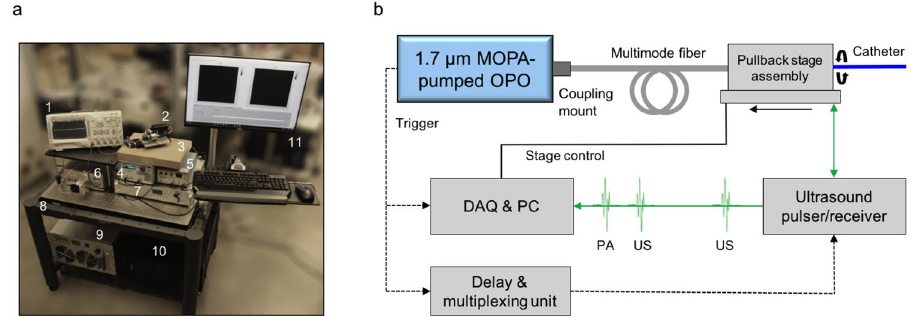
Figure 1. High-speed real-time IVPA-US imaging system. ( a ) Image of the portable IVPA-US imaging system. Major components: 1, oscilloscope; 2, fiber-optic rotary joint assembly; 3, IVPA-US catheter; 4, delay generator; 5, ultrasound pulser/receiver; 6, MOPA-pumped OPO; 7, laser controller; 8, mobile cart; 9, laser chiller; 10, PC and DAQ card; 11, image display monitor. ( b ) Schematic of IVPA-US imaging system layout. Dashed black line: trigger signal; solid black line: stage control cable; solid green line: radiofrequency